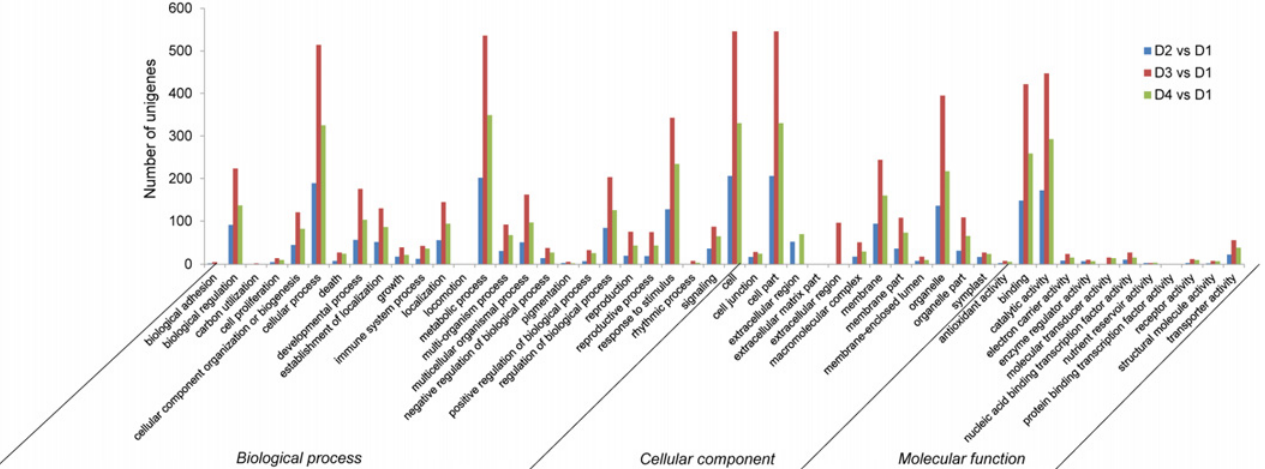
Fig 6. Gene Ontology (GO) functional classification analysis of differentially expressed transcripts (DETs) based on RNA-Seq data. GO functional classification analysis of DETs in D2 vs D1, D3 vs D1, and D4 vs D1. Based on sequence homology, 2,573 differentially expressed genes could be categorized into three main categories (biological process, cellular component, and molecular function), which include 25, 13, and 12 functional groups, respectively.